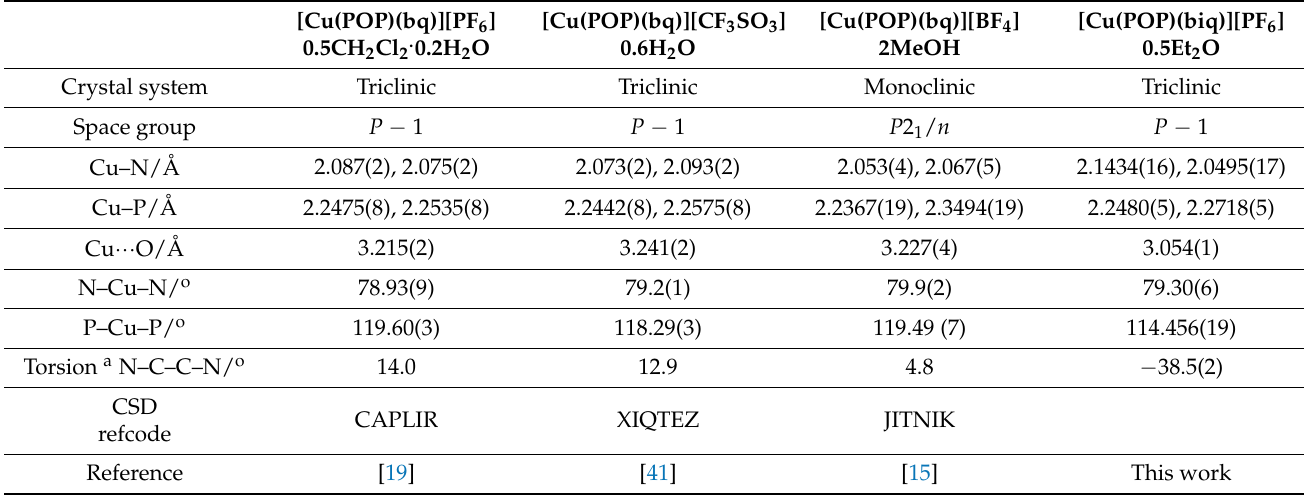
Table 1. Comparison of crystal and selected structural parameters in salts of [Cu(POP)(bq)] + and [Cu(POP)(biq)][PF 6